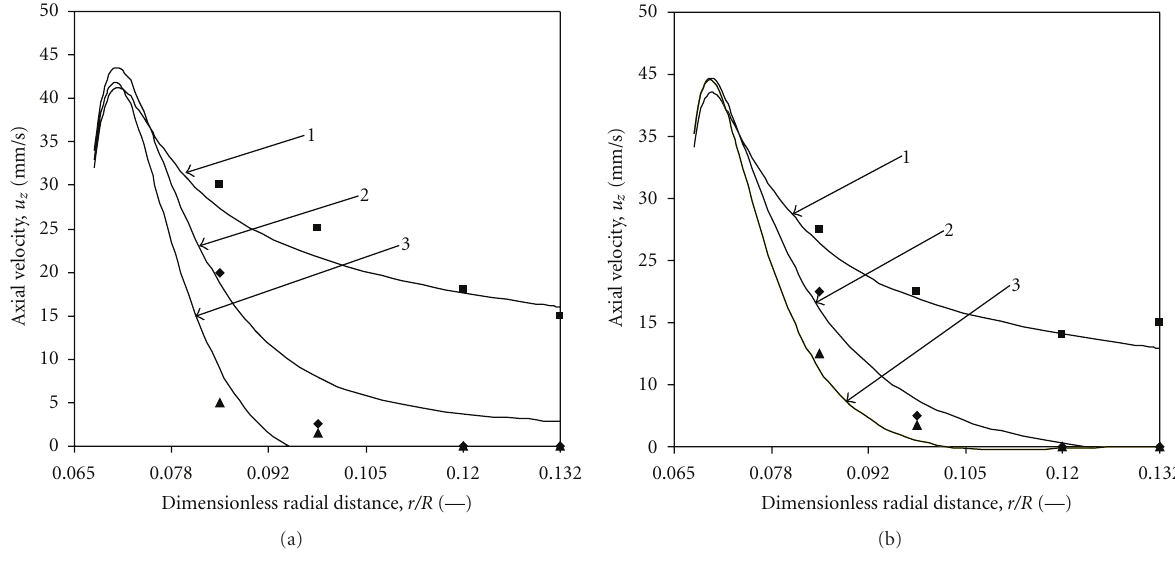
Figure 4: Axial velocity v/s , dimensionless radial distance. (a) Ra = 8 × 10 12 (b) Ra = 1 . 8 × 10 13 . Momentum equation is given